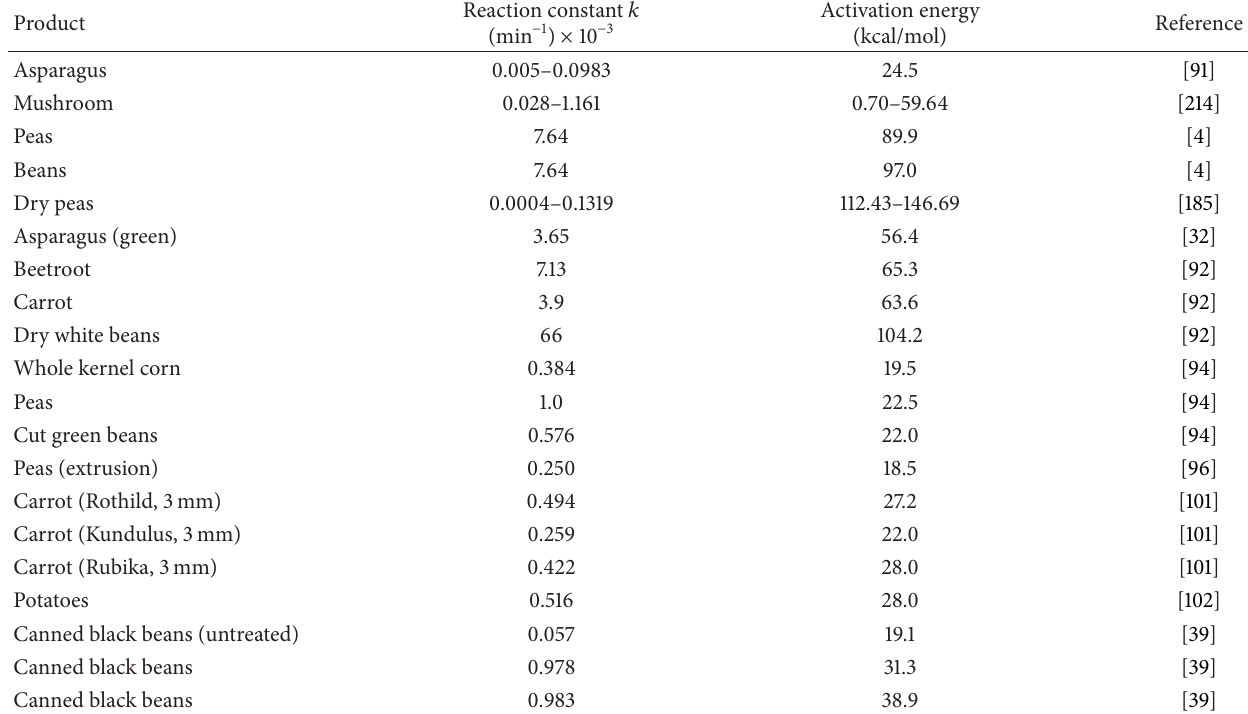
Table 8: Kinetic parameters for textural softening of